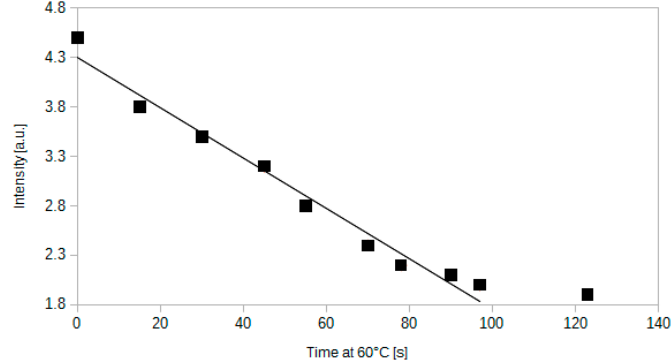
Figure 11. Dependence between the intensity of light transmitted through the sensor and the time after reaching 60 °C. Measurement performed at 0.1% of CO 2 in air.